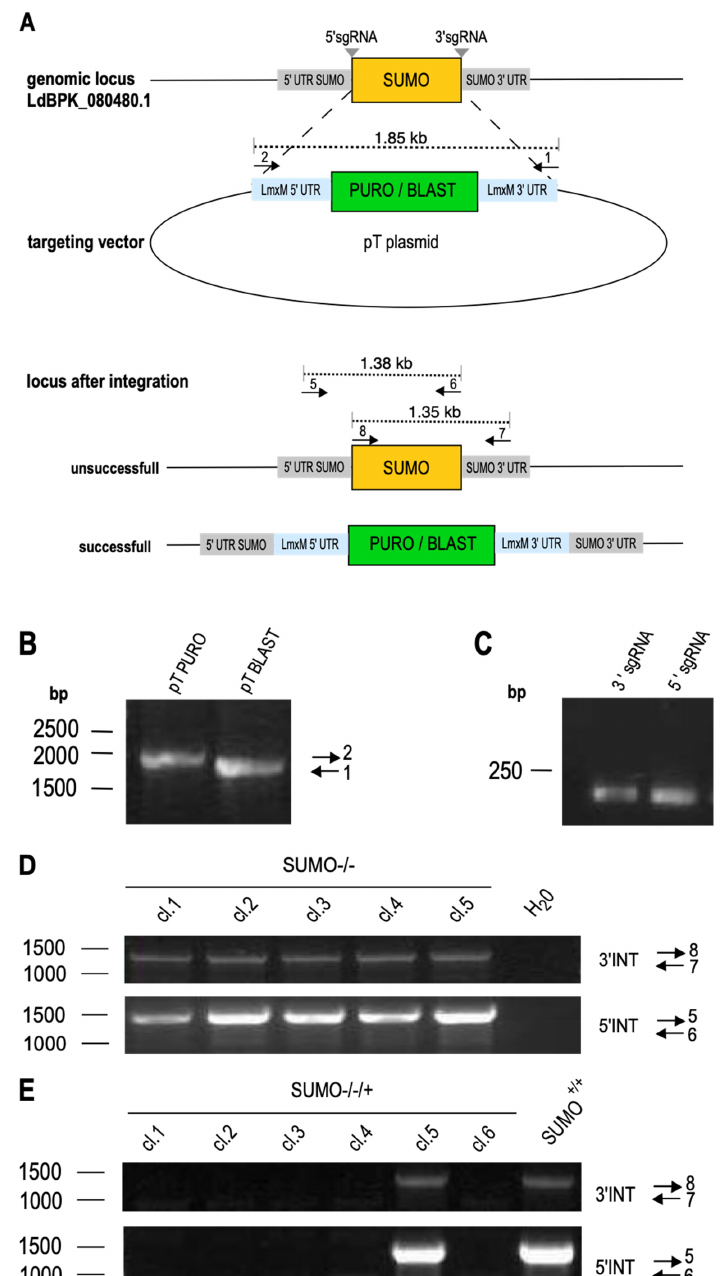
Figure 2. Replacement of SUMO in Leishmania donovani. ( A ) Schematic representation of LdBPK_080480.1 replacement using the CRISPR / Cas9 technology. SUMO -targeting sgRNAs (grey) and the replacement cassettes were PCR-amplified and transfected into a Cas9 / T7-RNAP-expressing L. donovani strain. Two sets of genotyping primers were used to test for the presence of the gene of interest (GOI) ( B ) Gene-specific replacement cassettes amplified from pTPURO or pTBLAST vector were analyzed by agarose gel electrophoresis and ethidium bromide staining. The position of the DNA size marker is indicated on the left, the primers used are indicated on the right. ( C ) Amplified sgRNA-coding sequences were separated on a 1% agarose gel and stained with ethidium bromide. ( D ) Genotyping of putative gene replacement mutant clones with primer pairs 7 + 8 or 5 + 6. PCR products were analyzed by 1% agarose gel electrophoresis. Positions of DNA size markers are shown to the left; the primer pairs are indicated on the right. ( E ) Genotyping of gene replacement mutants in the SUMO over expression background (SUMO − / − /+ ) indicated primer